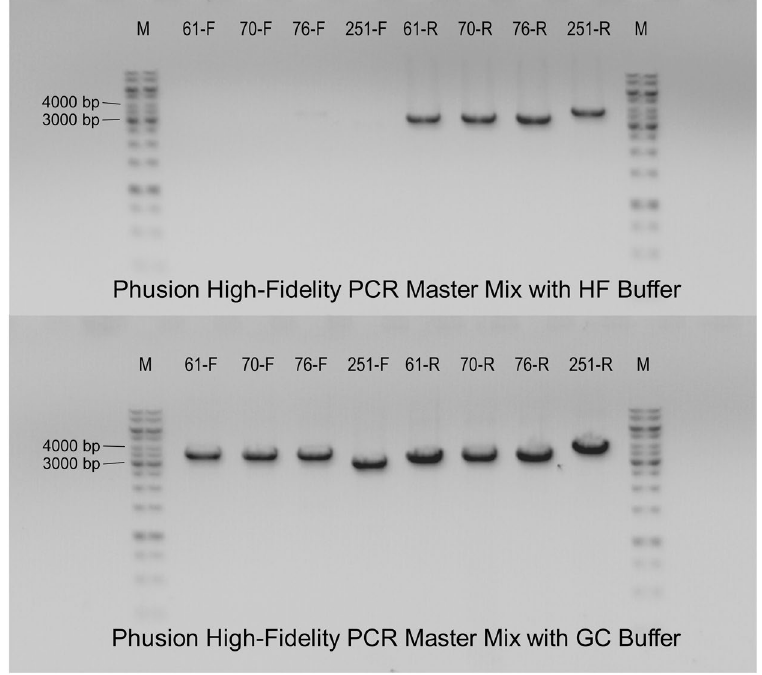
Figure 2. Agarose gel electrophoresis analysis of PCR fragments multiplied by Phusion High-Fidelity PCR Master Mix with HF Buffer and Phusion High-Fidelity PCR Master Mix with GC Buffer. Analysed PCRs are labelled as the mutated residue and the letter indicating whether the fragment is multiplied by mutation-specific forward (F) or reverse (R) primer. Expected PCR fragments are between 3000 and 4000 bp long. While using the PCR master mix with GC buffer gave expected fragments in all shown cases, using the Phusion High-Fidelity polymerase with HF buffer failed to multiply four